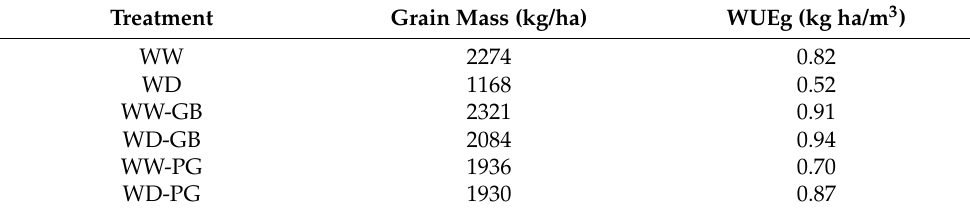
Table 3. Yield and grain water use